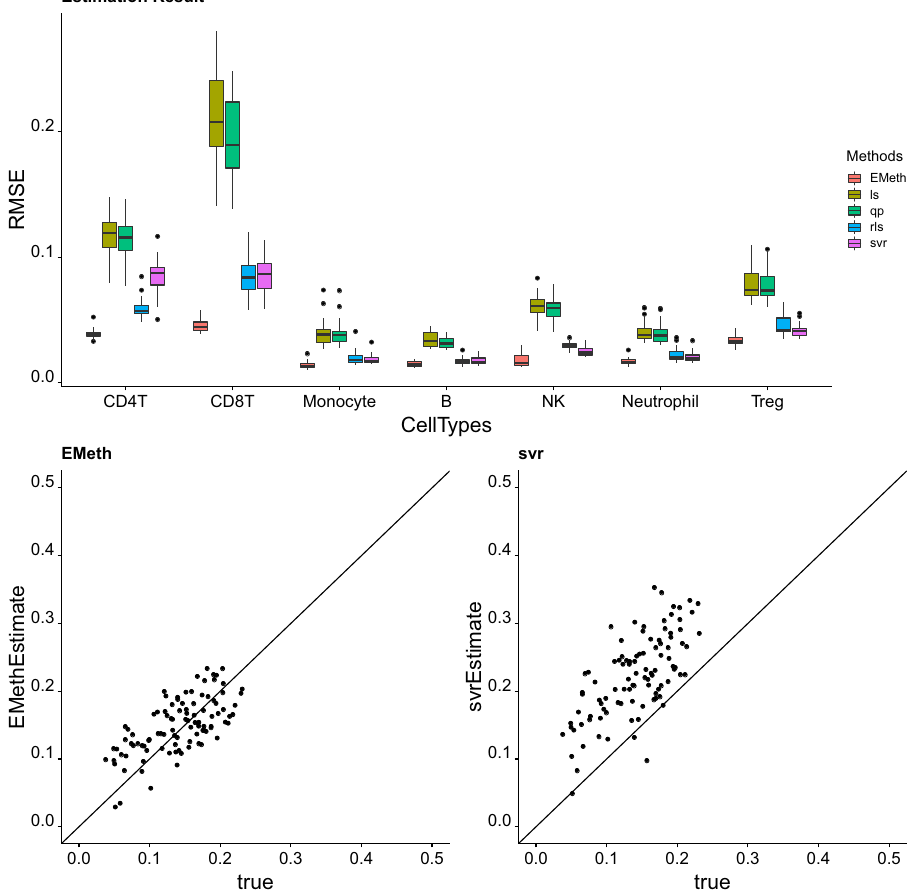
Figure 1. Evaluation of different methods using simulated data. The upper panel shows the RMSE in 25 repetitions of all five methods in one group of simulation parameters ( σ RMSE for each cell type separately. Under this setting, EMeth dominates the result in all cell types. Two panels in the bottom panel display estimates of CD4T proportions by EMeth and SVRs for 100 samples. In this case, both methods have reasonable performances, though SVR has a systematic bias. These plots were generated using ggplot2 version 3.3.1 24